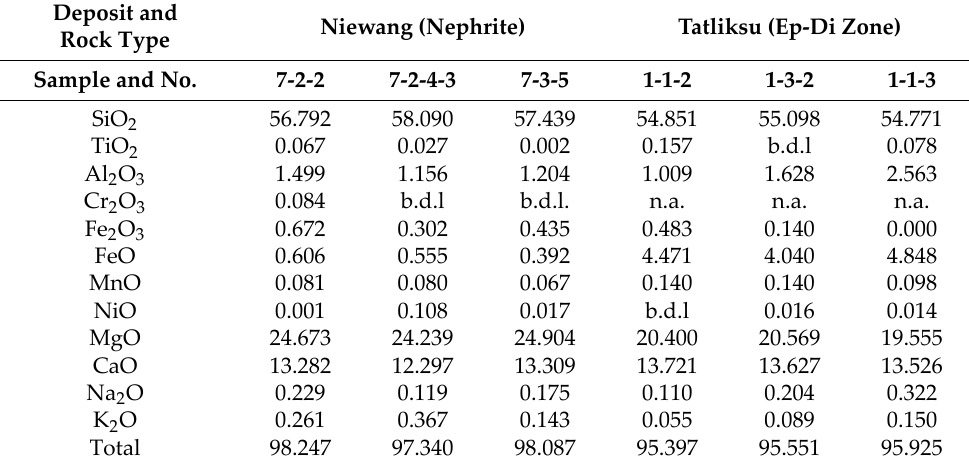
Table 2. Chemical compositions of tremolite‑actinolite from the studied nephrite deposits (wt.%) *. Deposit and Rock Type Sample and